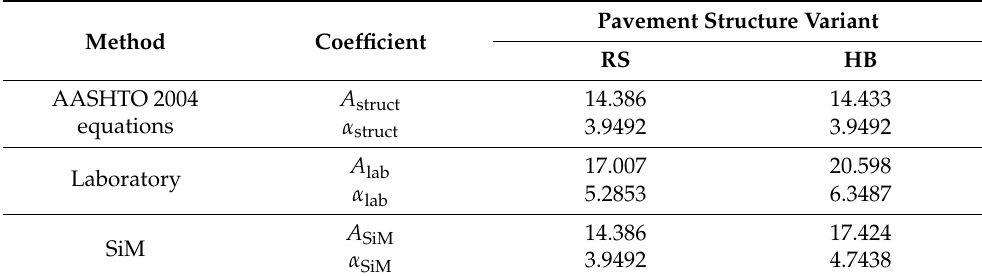
Table 6. Values of A and α coefficients from the formula (1) (fatigue curves) for the three methods of determination of the design lifespan of the structure at FC =